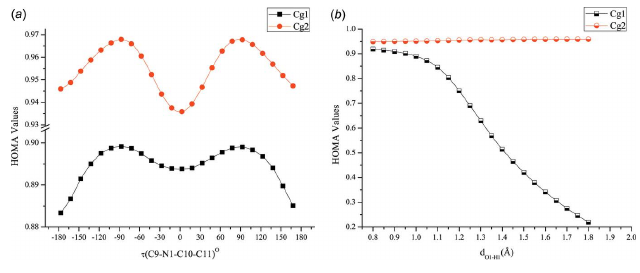
Figure 5 Graphics showing the variation of HOMA values with scan coordinate.